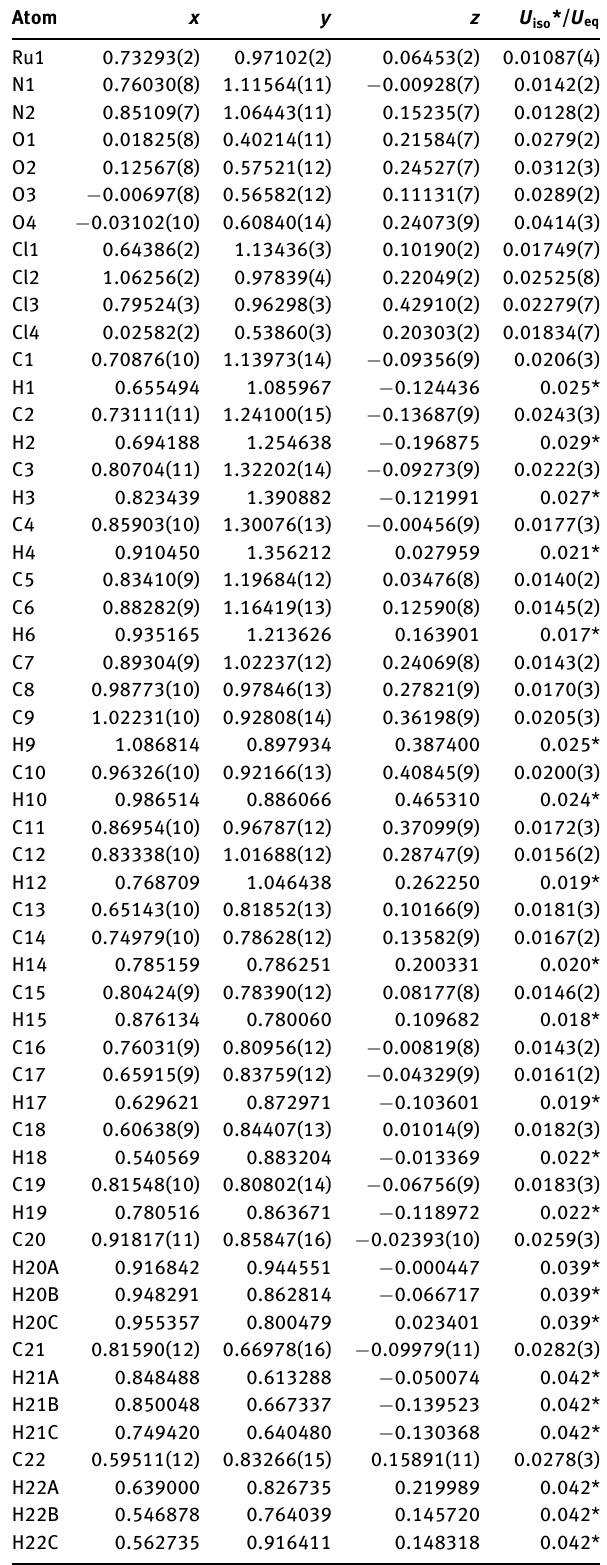
Table 2: Fractional atomic coordinates and isotropic or equivalent isotropic displacement parameters (Å 2